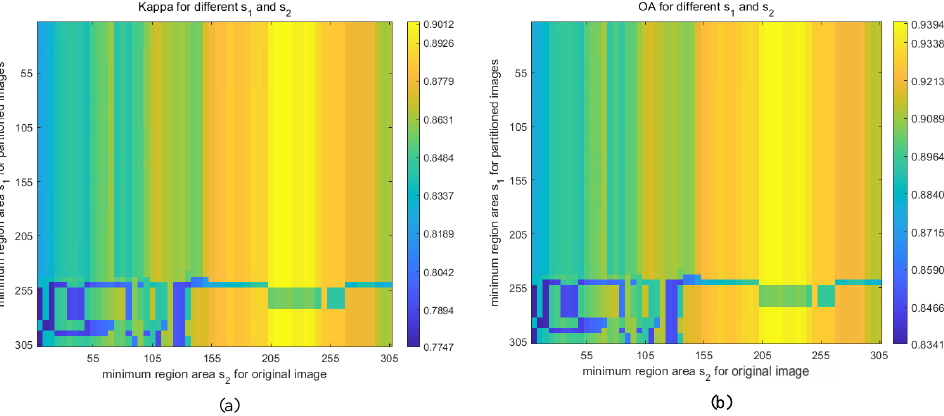
Figure 3. Kappa and OA for different α (length of the overlapping area) from 28 to 112 with step 2.